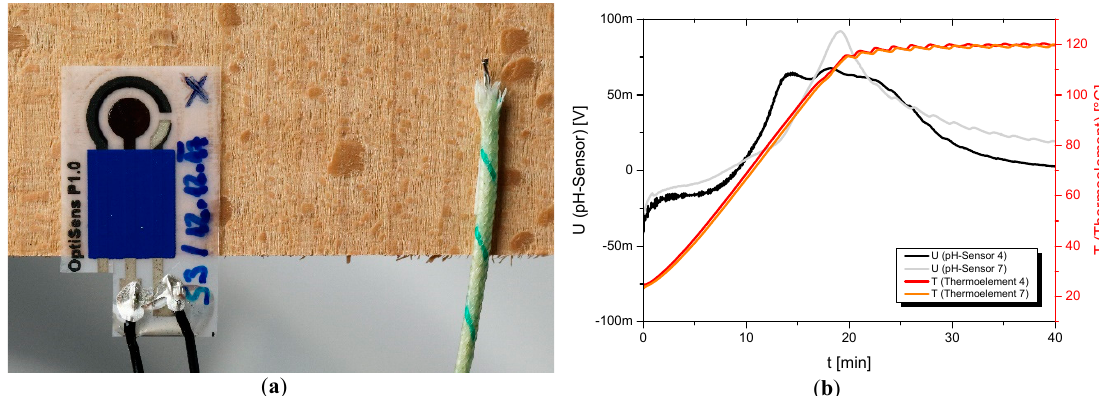
Figure 4. ( a ) Integration of the printed proton sensor for the in-situ measurements of cross-linking and the thermocouple; ( b ) in-situ measurements of pH and temperature during the hot-press gluing